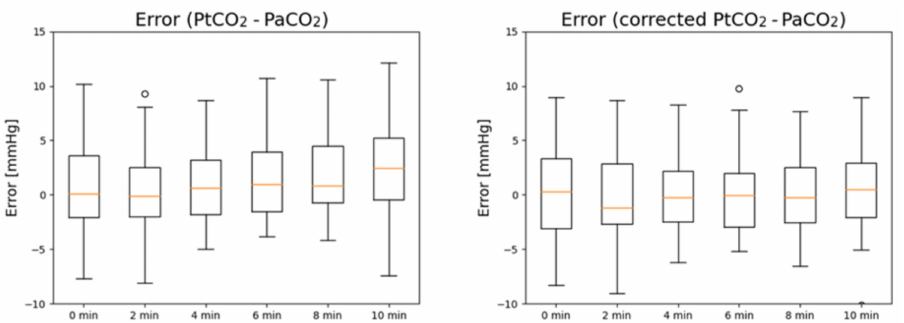
Figure 2. Boxplots of the measurement errors of PtCO 2 ( left ) and corrected PtCO 2 ( right ) at different timestamps with respect to PaCO 2